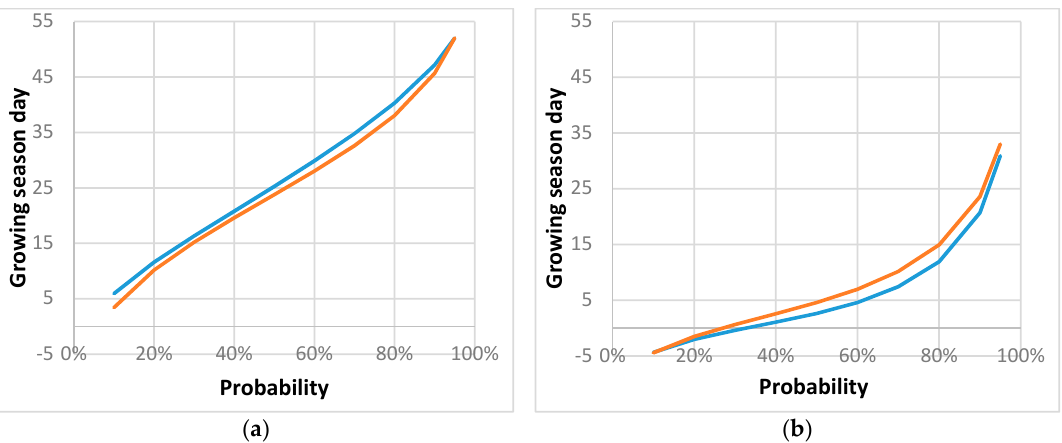
Figure 7. The probability curves of the last spring frost described by a day number in the growing season in the period of 1961–1990 (blue line) and 1991–2020 (orange line). ( a ) Poznan for Tmin < 0 °C, ( b ) Sandomierz for Tmin < − 2 °C.